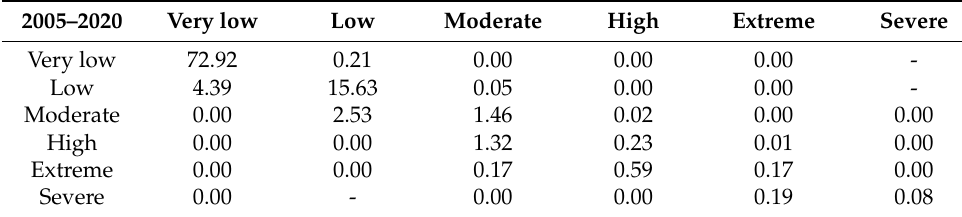
Table 6. SEI, SEA, and SER of LU types.